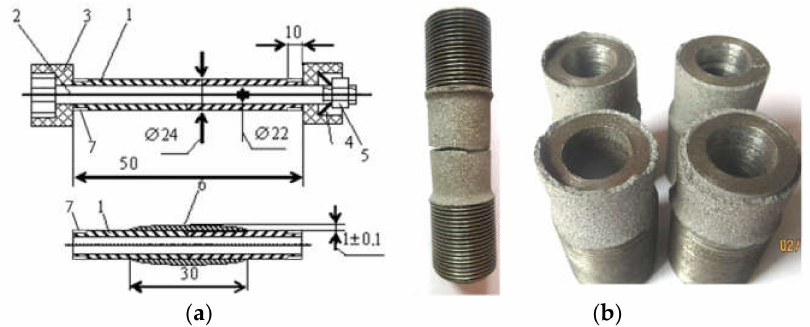
Figure 4. Schematic diagram of the experimental measurement of stresses in the coating dur- ing its spraying: 1—ring with a longitudinal section (specimen); 2—electrometallizer; 3—oating; 4—extension rods for fixing the beams of strain-gauge sensor; 5—beam; 6—load cell; 7—strain-gauge sensor body; 8—electric motor; 9—the central rod fixed on the ring, around which the ring rotated in the process of spraying; and 10—device for registering the relative displacement of the ring ends.